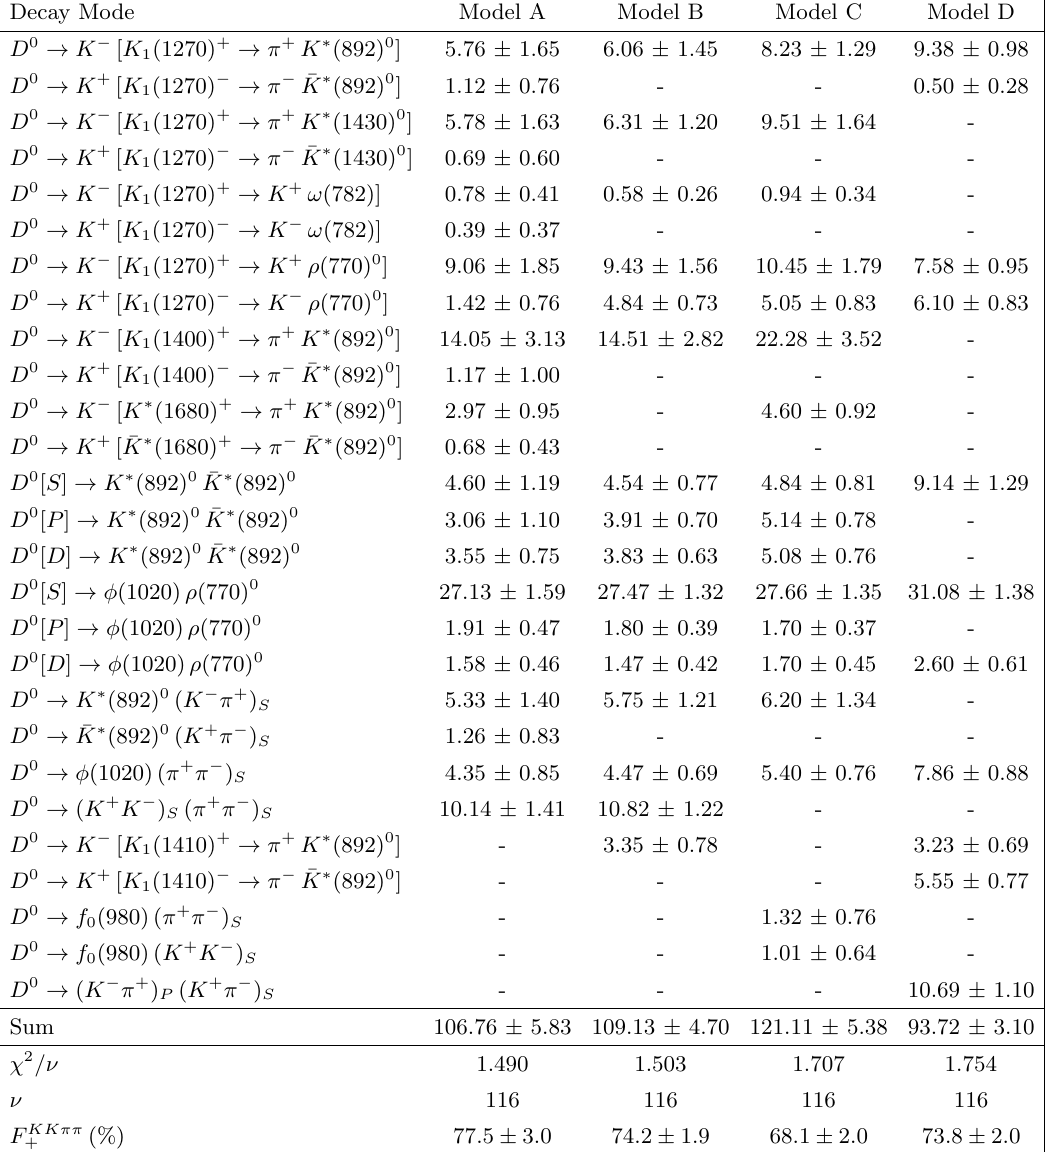
Table 20 . Fit fractions in percent for each component of various alternative models for D 0 ! K + K (cid:0) (cid:25) + (cid:25) (cid:0) based on (cid:12)t quality. The F KK(cid:25)(cid:25) and (cid:31) 2 =(cid:23) values are also given. The uncertainties + are statistical only.